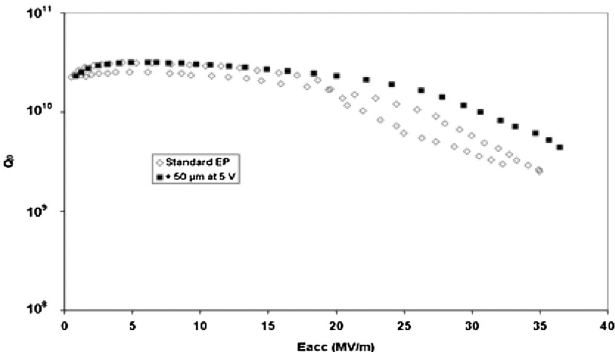
FIG. 12. Successive rf results at 1.4 K on the single-cell 1DE1 cavity after standard EP at 17 Vand LV-EP at 5 V. No decrease in performance is observed after